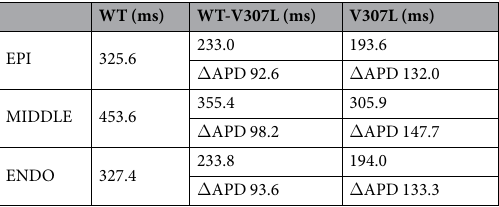
WT (ms) WT-V307L (ms)